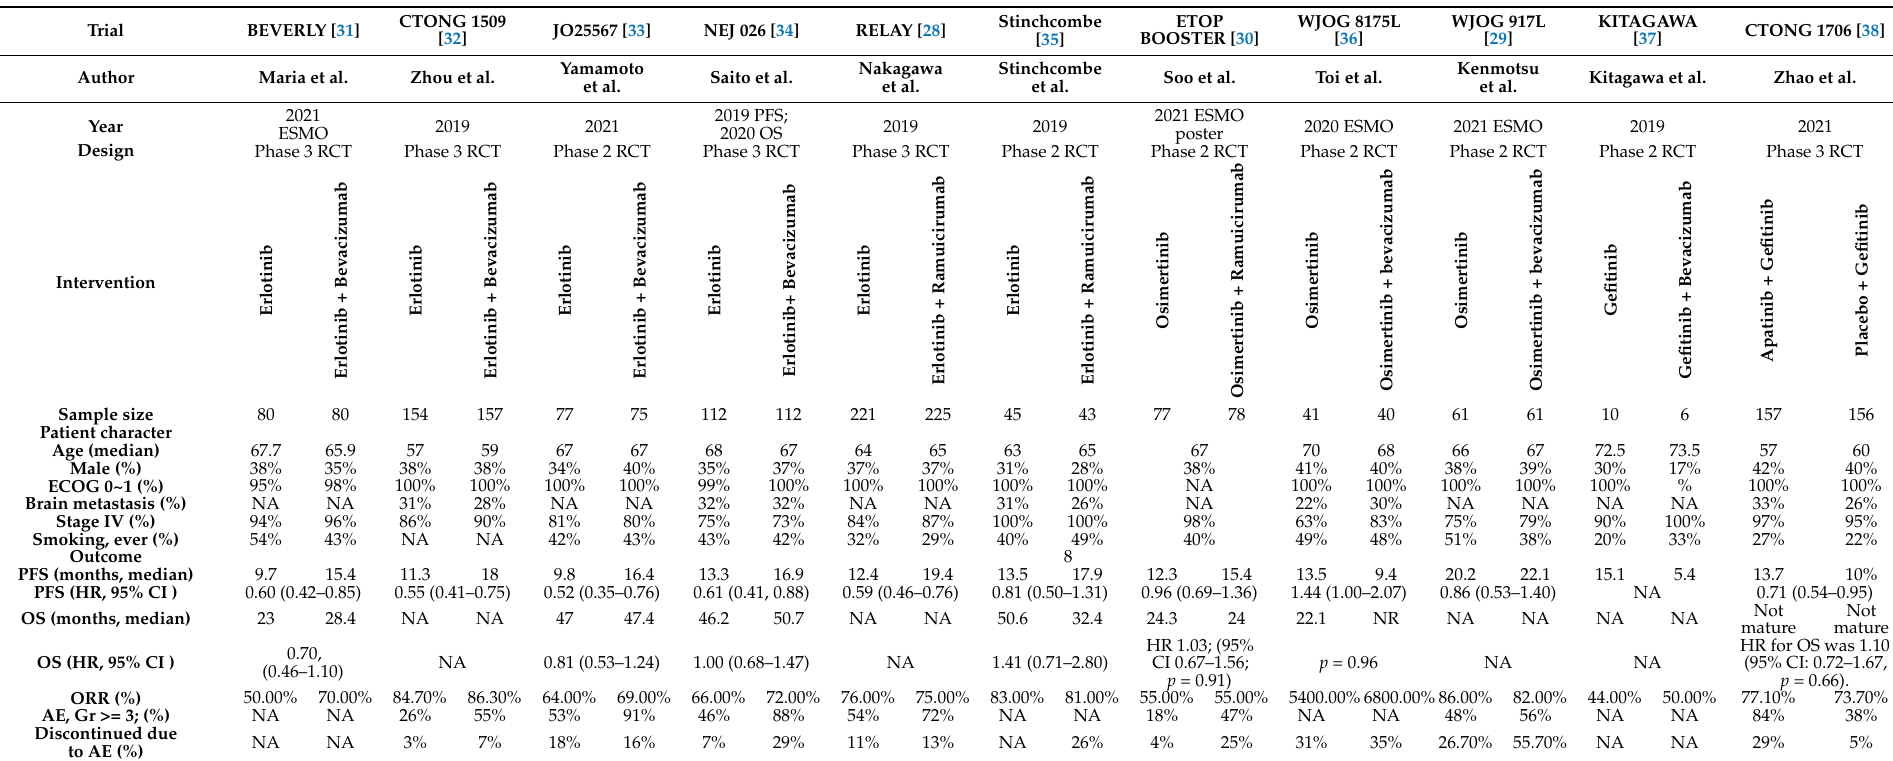
Table 1. Characteristics of included